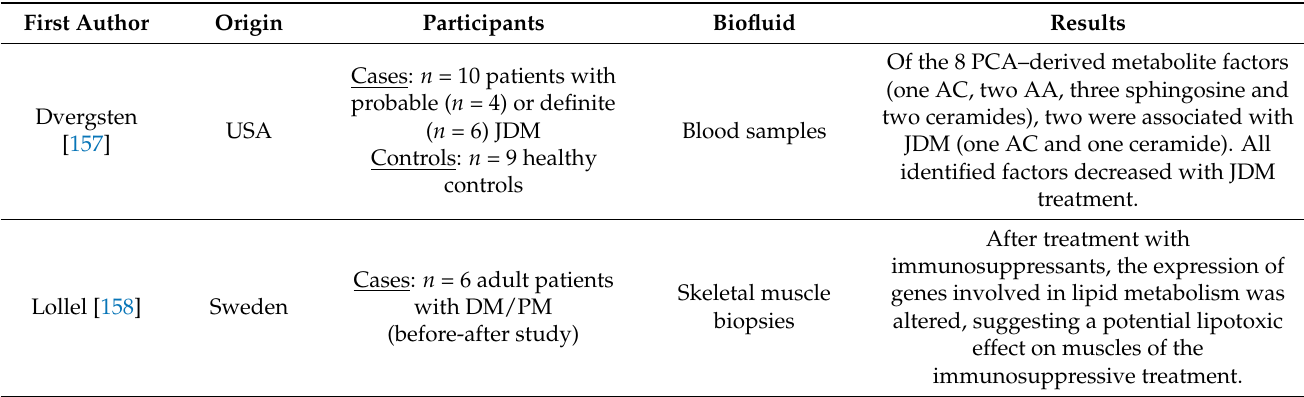
Table 7. Summary of studies assessing ceramide levels in patients with